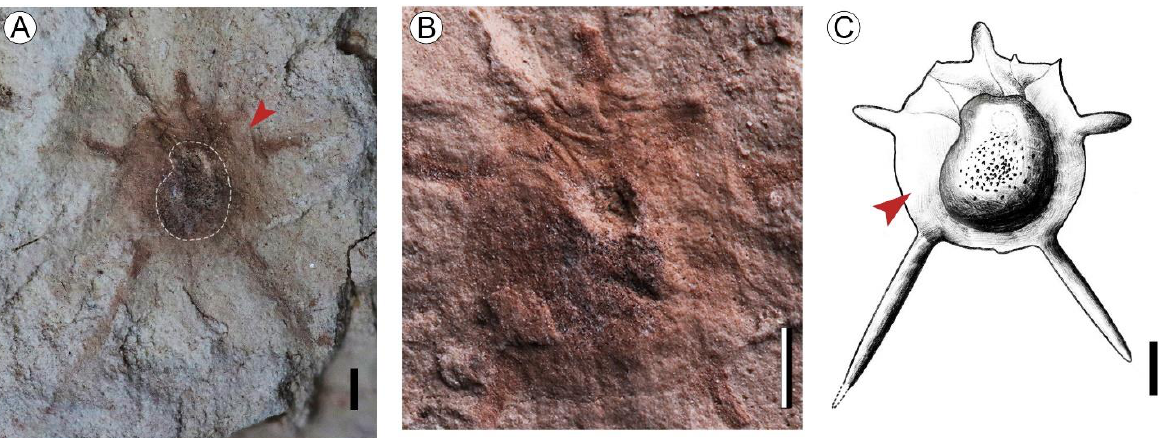
Figure 2. Fossil and reconstruction image of Ceratophyllum cf. muricatum Chamisso from the Maoming Basin. ( A ) Fossil fruit of C. cf. muricatum with five prominent spines, red arrow shows marginal wing, the dotted line shows the position of seed, MMJ3–2907. ( B ) Enlargement of A, the middle part of the fruit exhibits a granular surface texture. ( C ) Fossil reconstruction, red arrow shows marginal wing. Scale Bars = 1